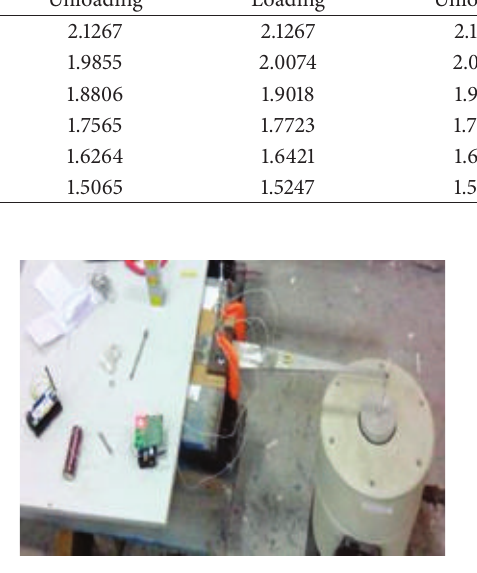
Figure 10: Vibration exciter.